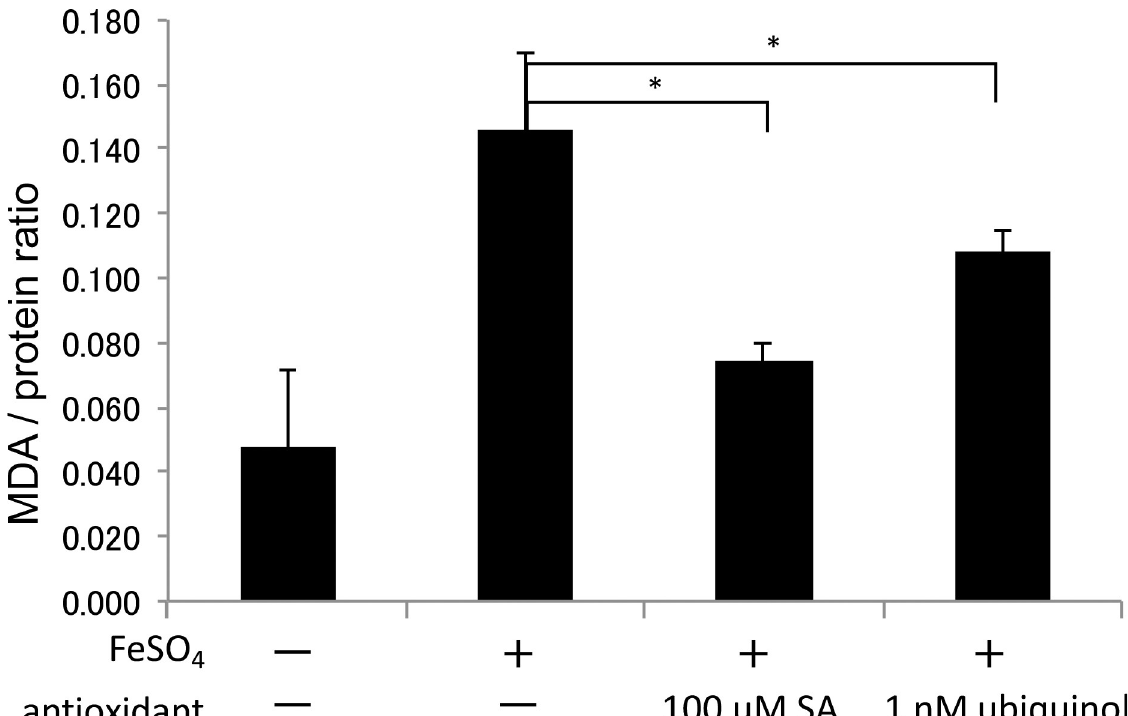
Fig 5. Detection of MDA (lipid peroxidation) in HSG cells. In human salivary gland (HSG) cells, lipid peroxidation induced by 100 μ M FeSO 4 was inhibited by 100 μ M sodium ascorbate (SA) and 1 nM ubiquinol. Values are presented as the mean ± standard deviation (n = 3). Significant differences: � p < 0.05, �� p < 0.01.